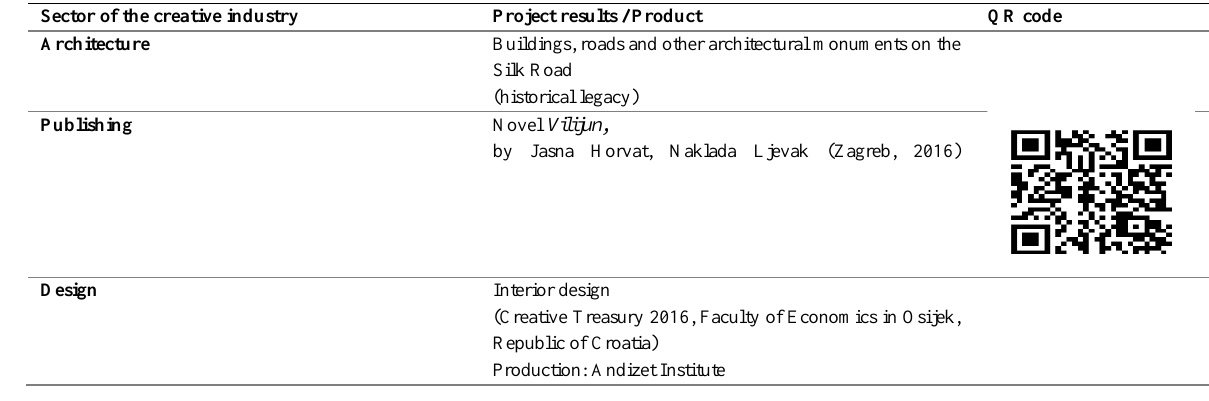
Table 3: Diversified products of the Vilijun